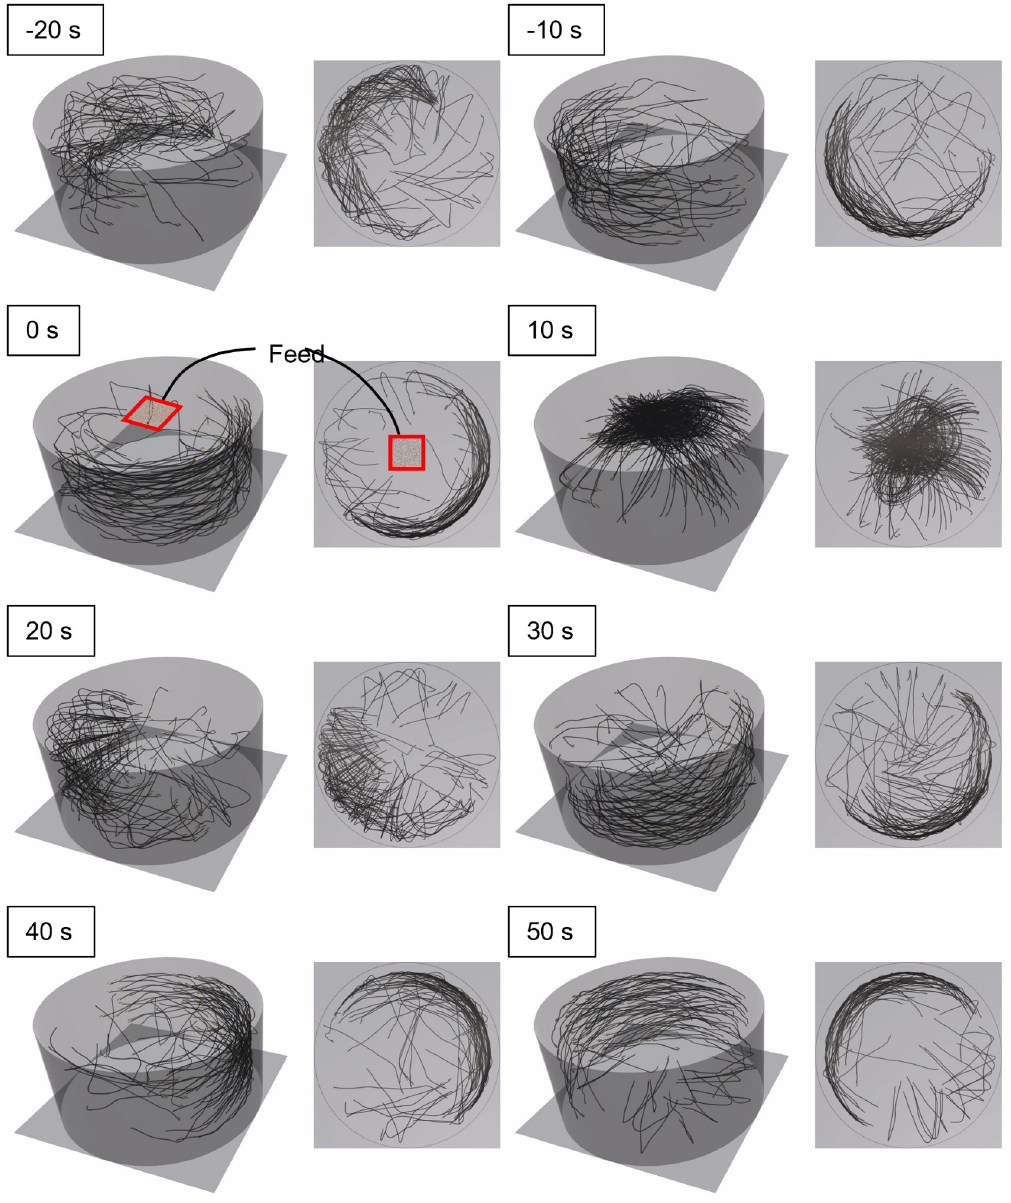
Fig 7. Individual movement paths for the Feeding C group. The elapsed times from the initiation feeding are